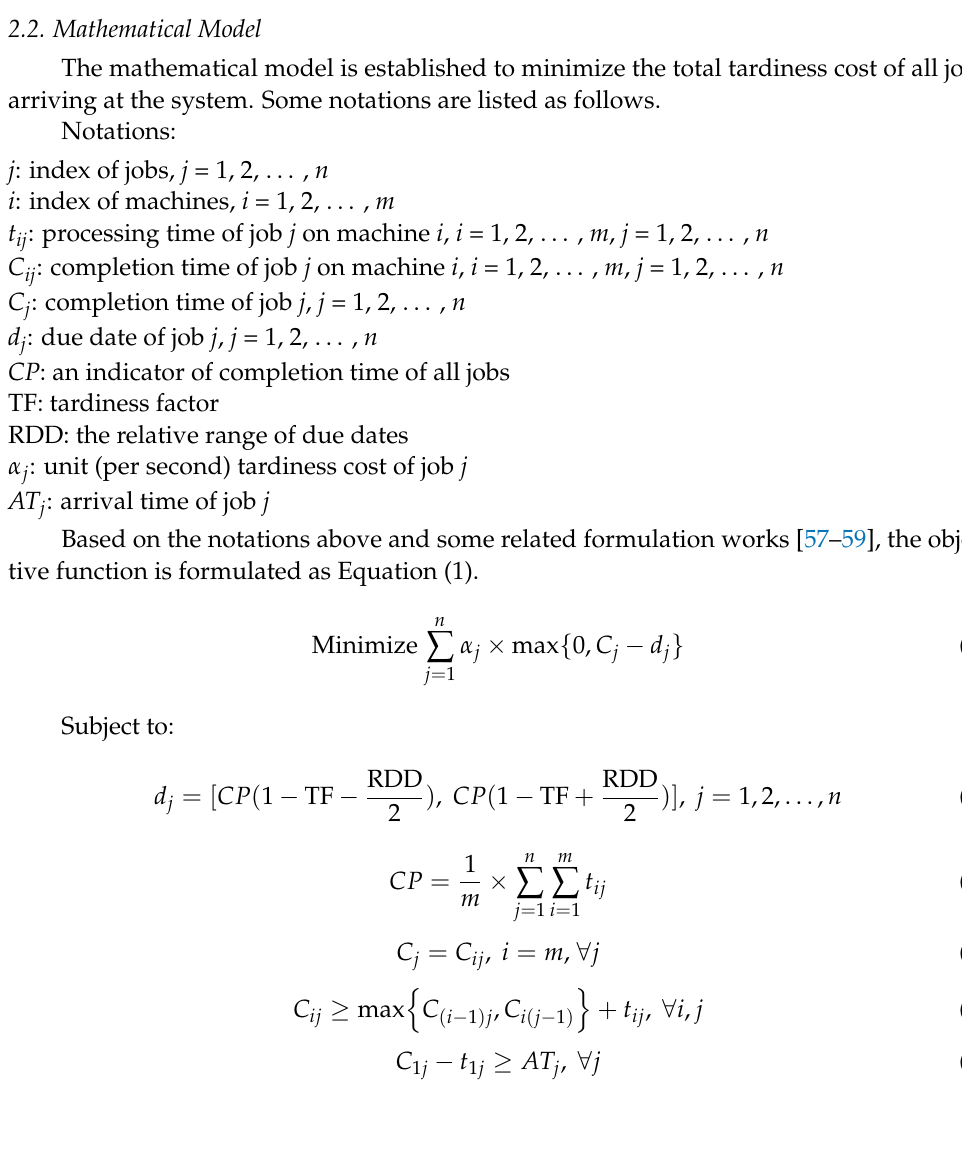
Figure 1. The system architecture of solving dynamic PFSP using DRL.